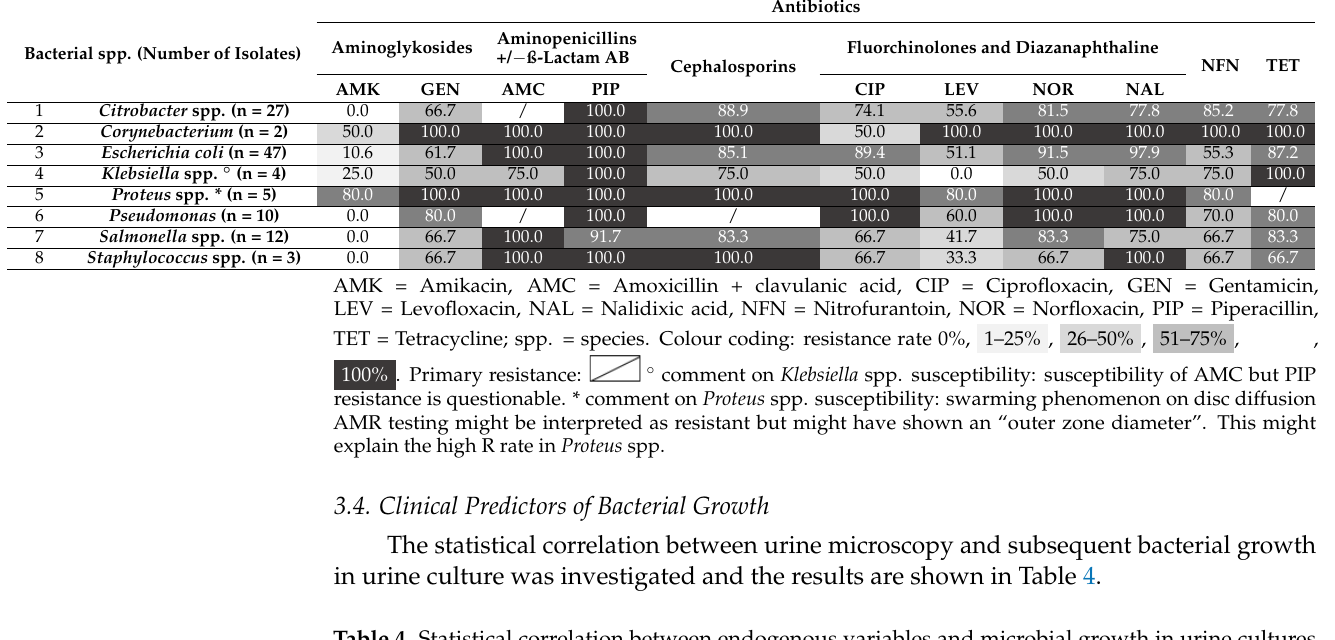
Table 4. Statistical correlation between endogenous variables and microbial growth in urine cultures (HPF = high power field).